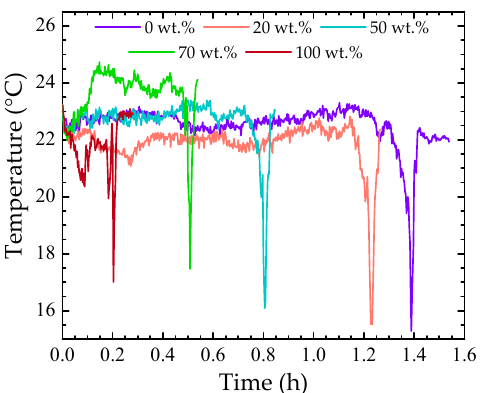
Figure 10. Temperature profiles of the 0 wt.%, 20 wt.%, 50 wt.%, 70 wt.%, and 100 wt.% solutions. Notice that there is an abrupt decrease in the temperature in all the temperature pro- files, forming an accentuated dip. Although the MZI response, used to track temperature variations, is sensitive to only this parameter, the measured value is not realistic. On the